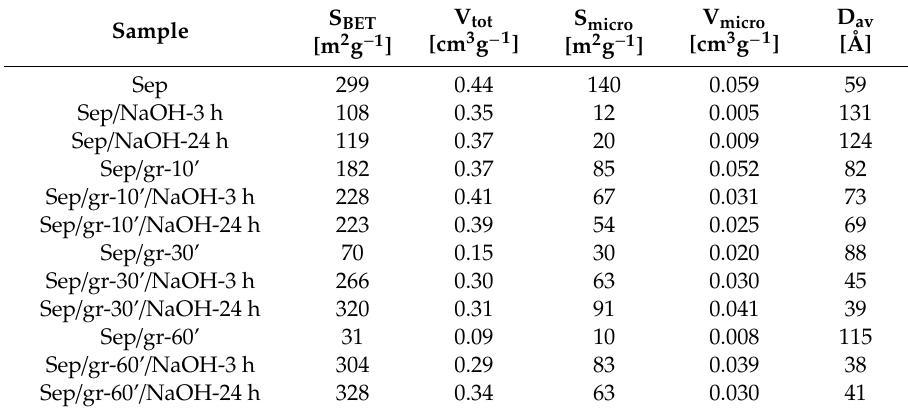
Table 3. Textural parameters from N 2 adsorption / desorption isotherms at − 196 ◦ C (S BET , V tot , S micro , V micro , D av